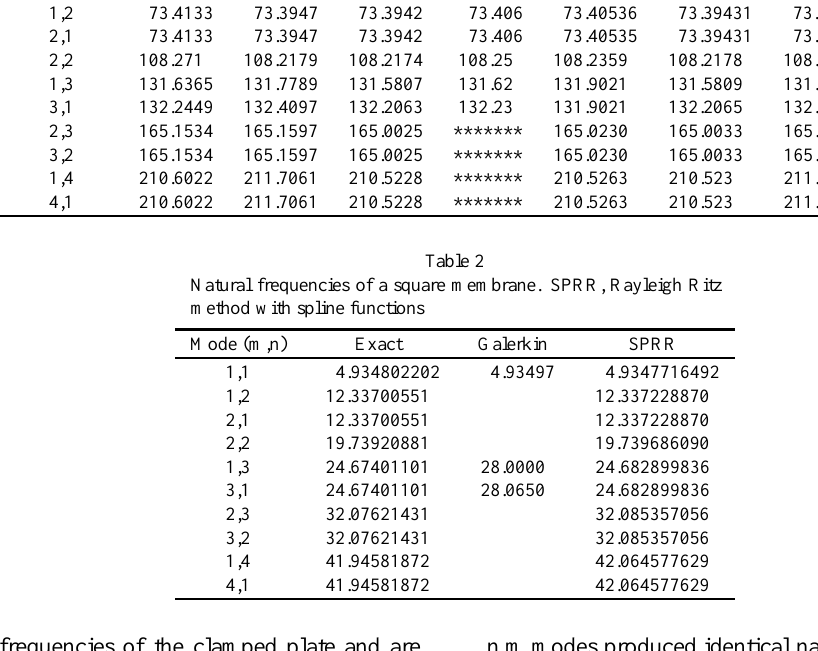
Natural frequencies of plate with all edges clamped. Ω = ωa 2